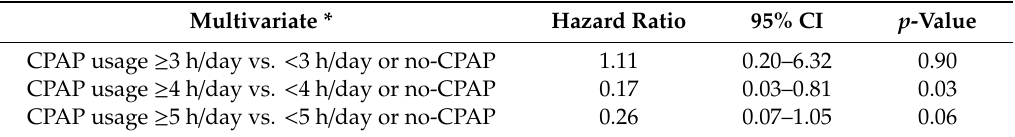
Table 3. Cox regression analysis of the association between time-dependent CPAP usage (hours / day) and adverse cardiovascular outcomes in 171 revascularized patients with ACS and non-sleepy OSA. (37 patients reached the composite endpoint).